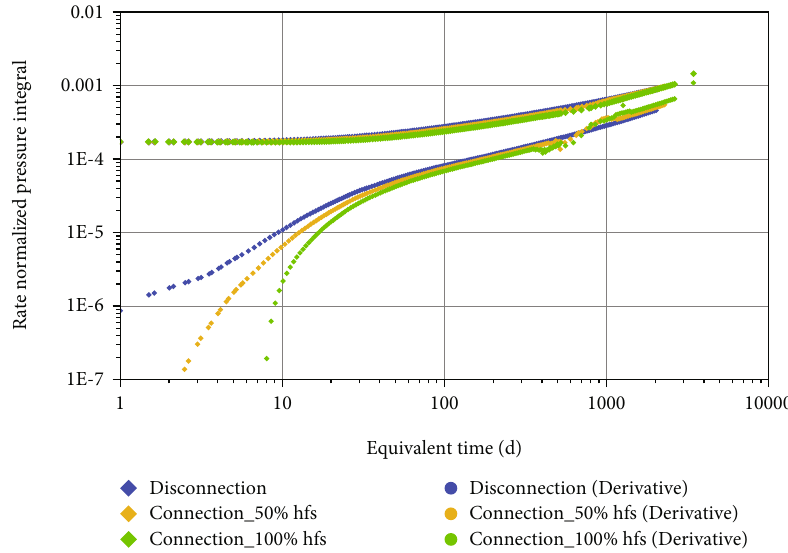
Figure 6: Log-log type curves of di ff erent well connection conditions considering only hydraulic